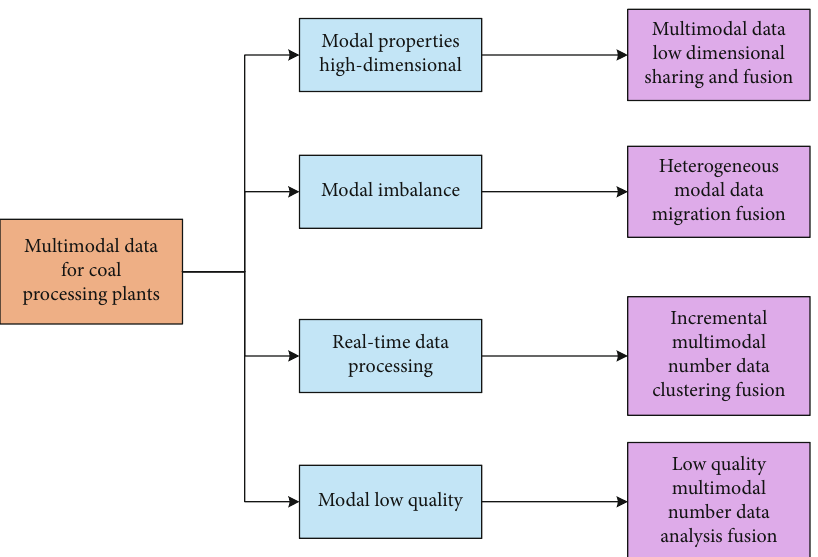
Figure 5: Main research elements of multimodal data association fusion